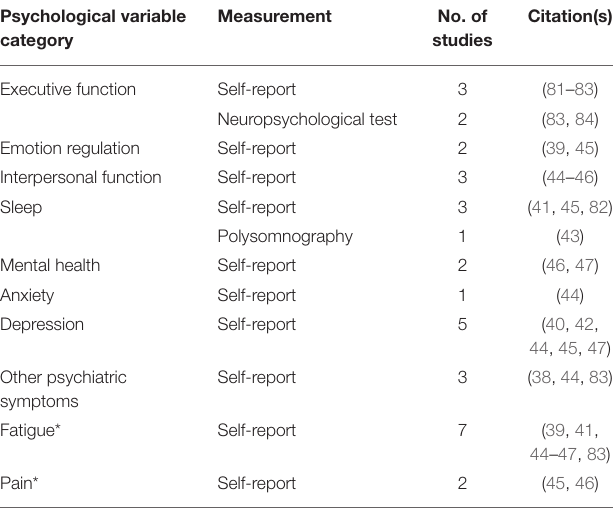
TABLE 2 | Categories of psychological variables, details on measurement, the number of studies investigating variables related to each category, and the associated